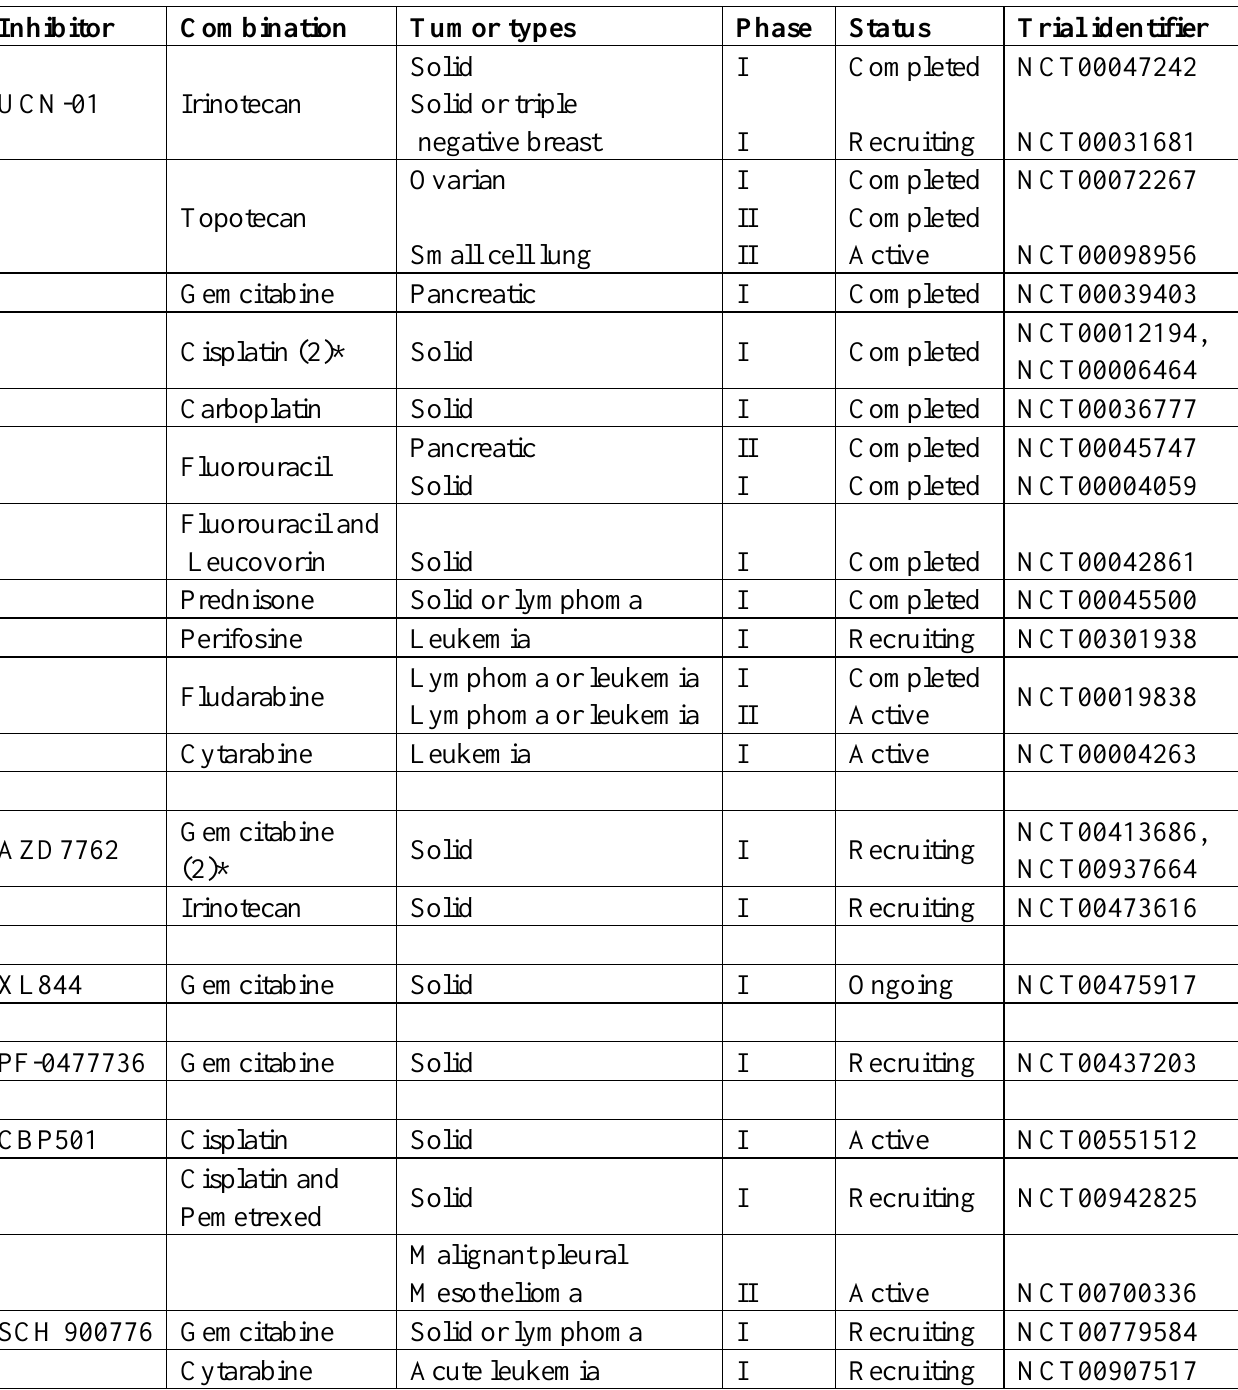
Table 1. Clinical trials of checkpoint inhibitors in combination with DNA damaging agents or other